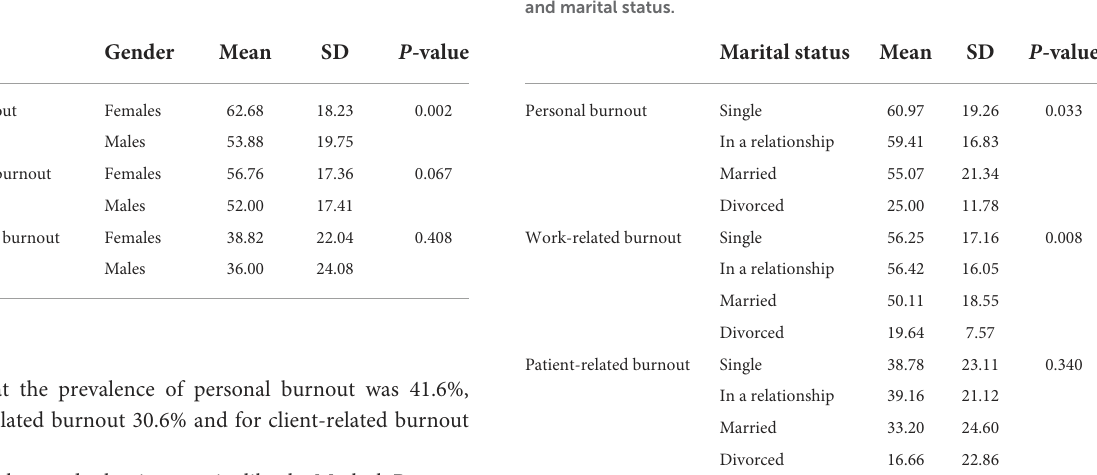
TABLE 3 Independent T -test between the mean of the three scales and gender.